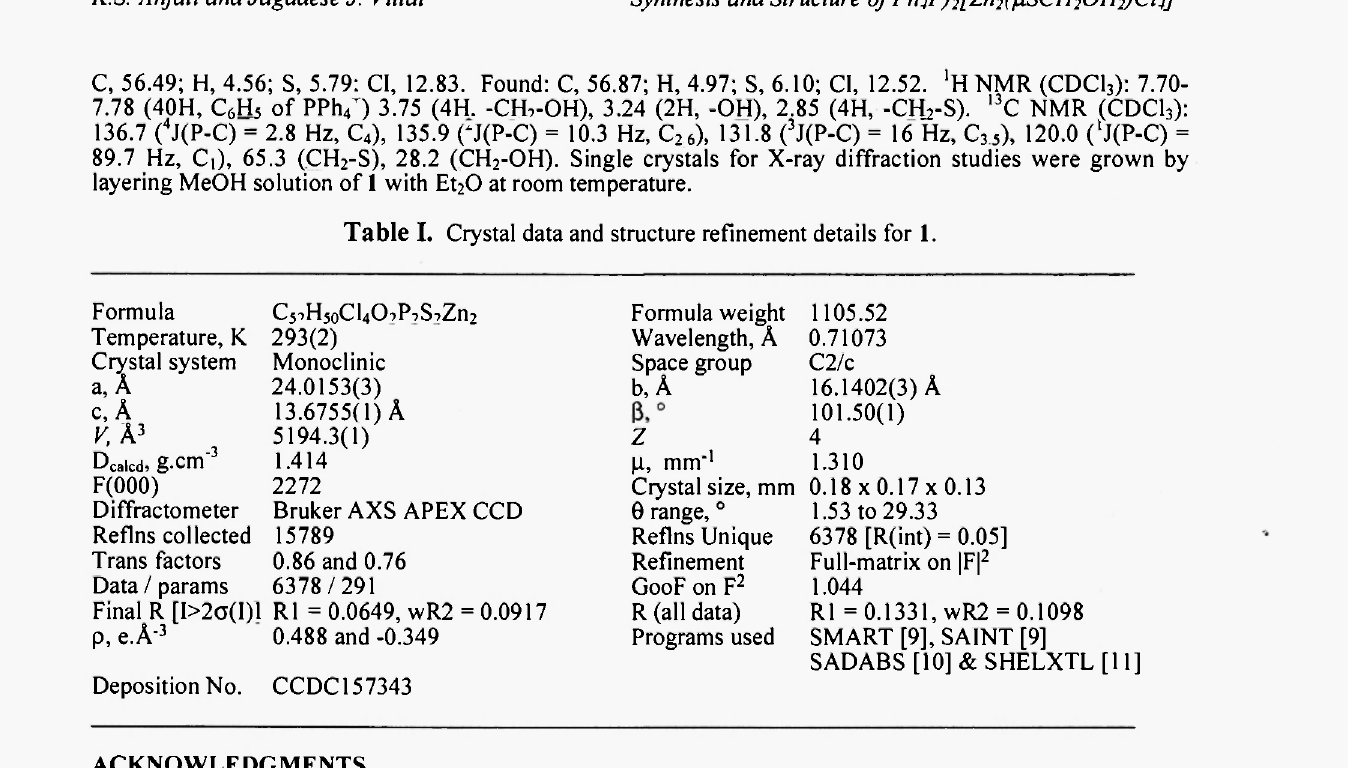
Table I. Crystal data and structure refinement details for